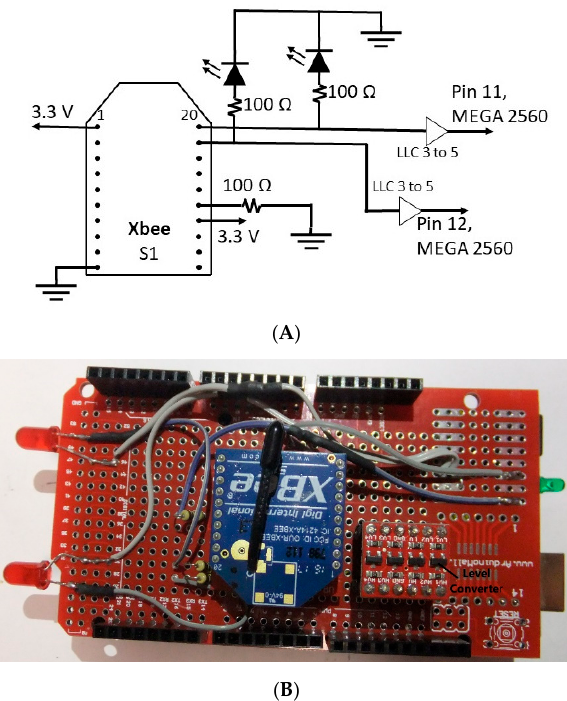
Figure 6. ( A ) Transmitter circuitry; ( B ) prototype transmitter. LLC 3 to 5: logic level converter 3 V to